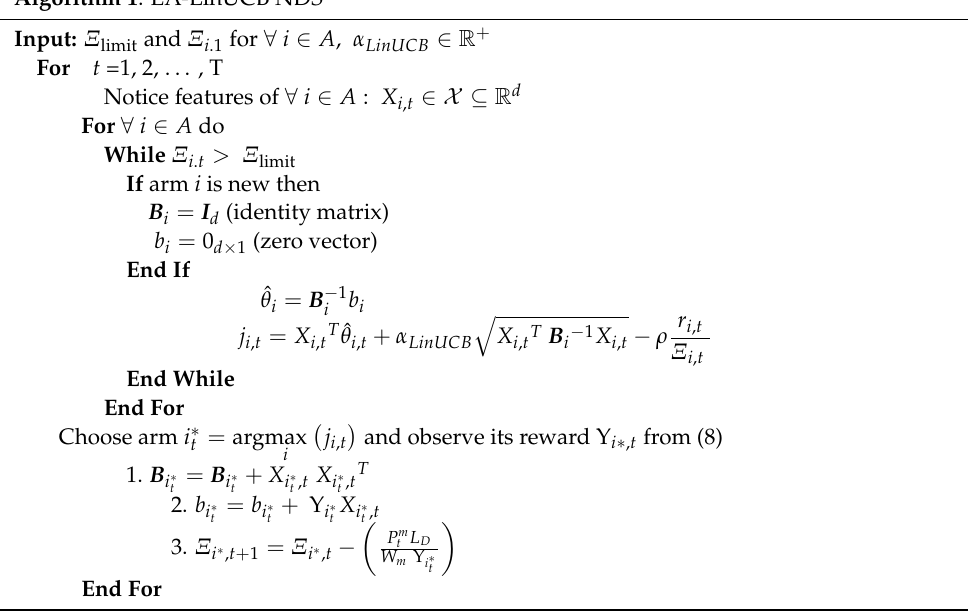
Algorithm 1 : EA-LinUCB